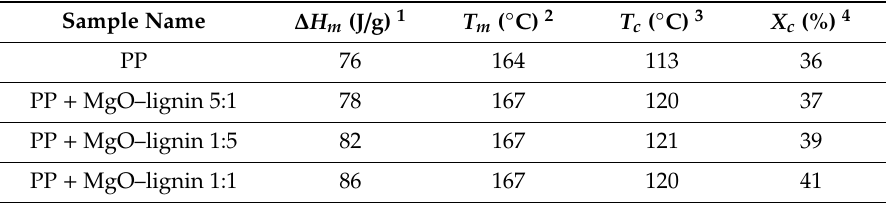
Figure 5. Di ff erential scanning calorimetry (DSC) curves for polypropylene (PP) + MgO–lignin 1:5. Table 4. Data obtained from DSC curves.